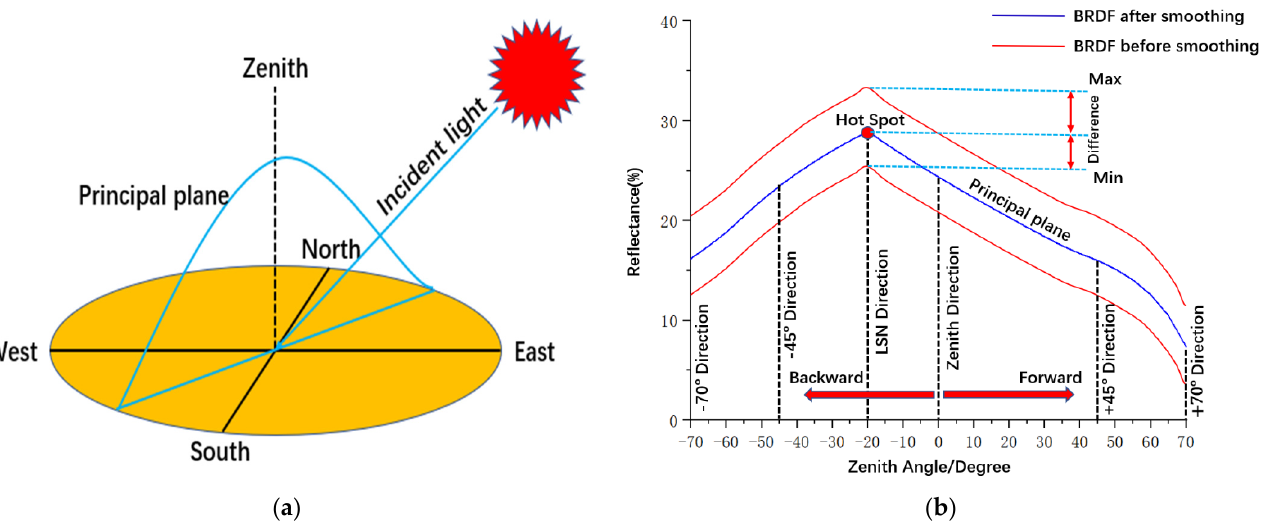
Figure 5. Schematic diagram of the BRDF principal plane and characteristic directions in the principal plane. ( a ) Principal plane of BRDF; ( b ) Characteristic directions of principle plane.